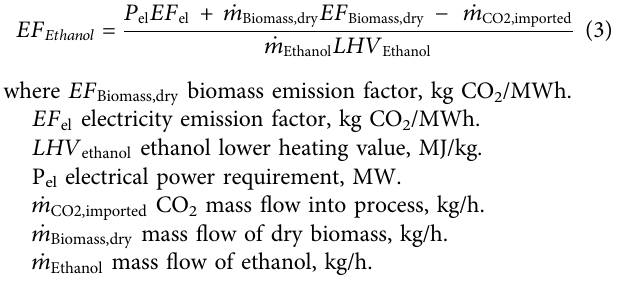
The consumption-based emission factors used are shown in Table 1 . The system boundary for the calculation is the production site including scope one and two emissions. For the emission factor for electricity, two scenarios based on the German and Finnish grid mix are calculated. For case C, additional carbon dioxide can be added to the process. The added CO 2 is of biogenic origin, which is consumed and bound to the ethanol product and can therefore be considered with negative emissions in the calculation as it is a sink for CO 2 .